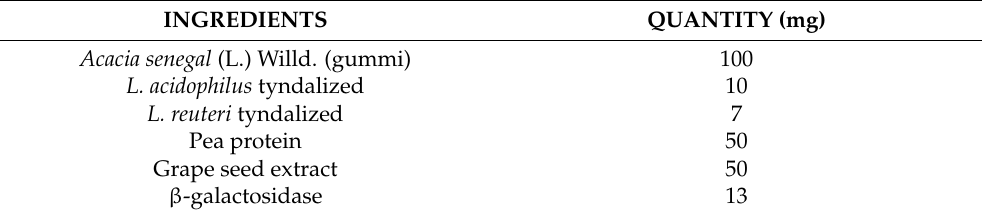
Table 1. NTN formulation. The table indicates the NTN components and the relative dosage. Doses were converted on the basis of mouse body surface formulation.